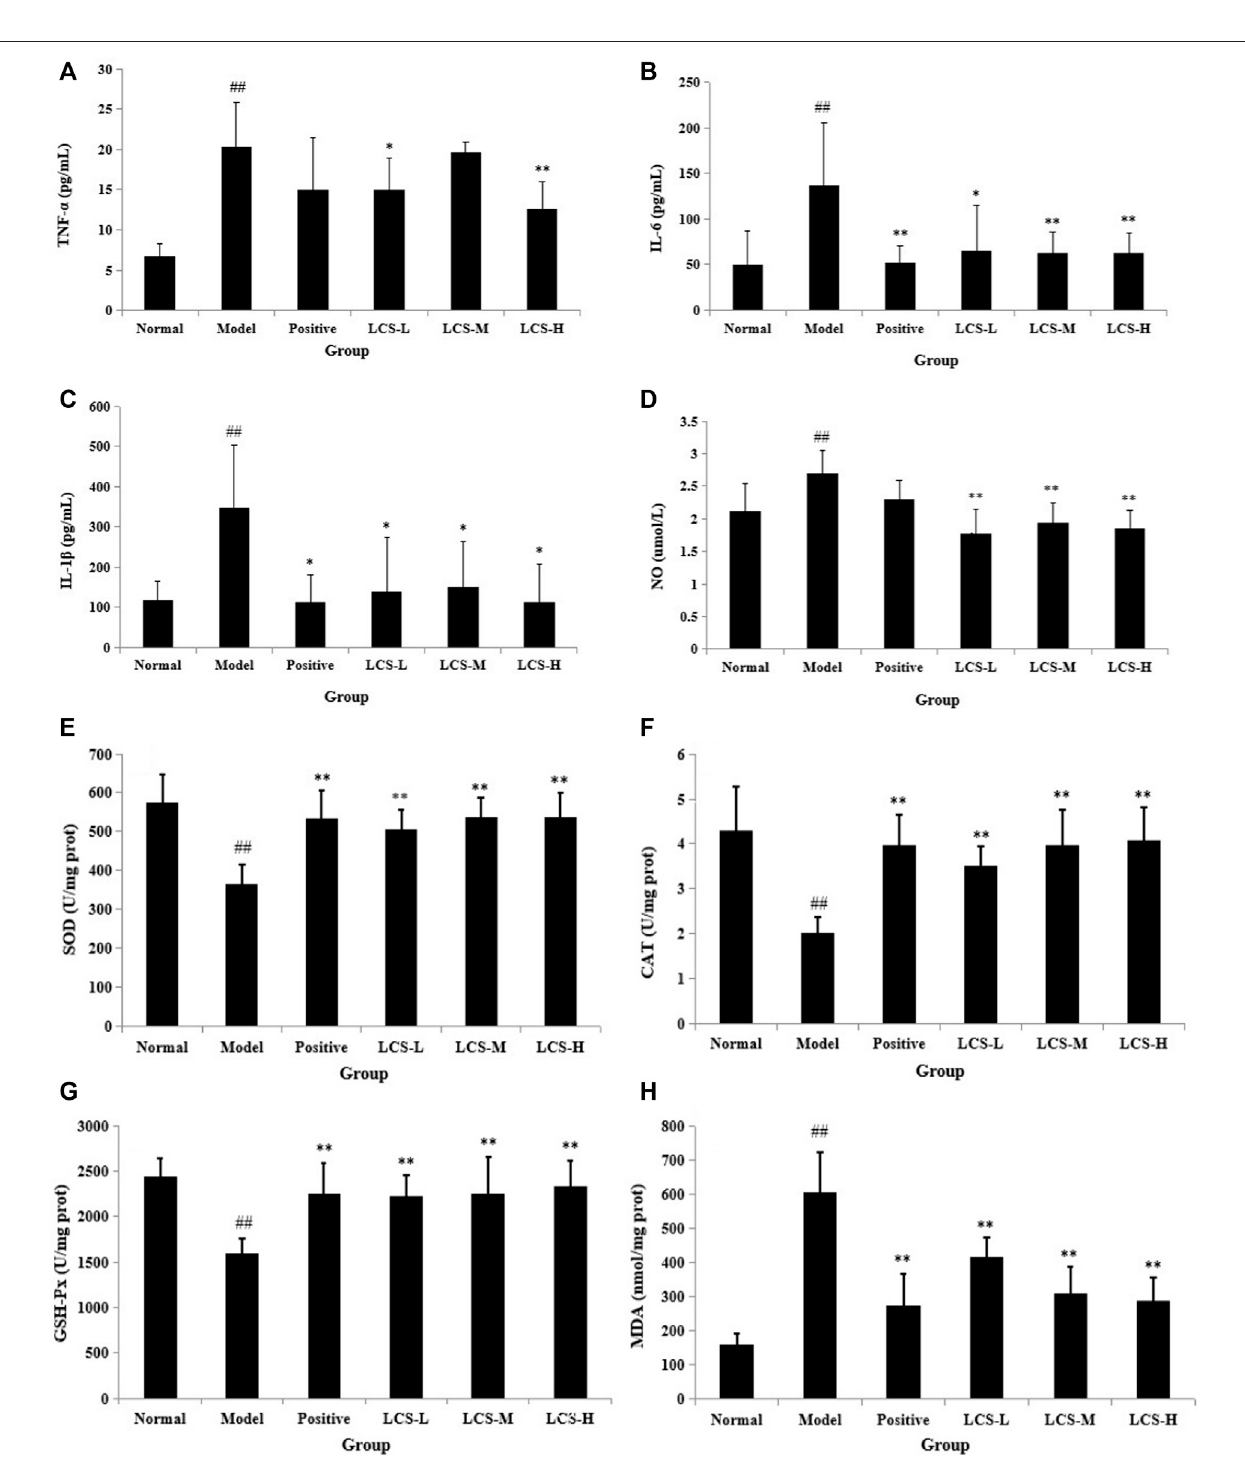
FIGURE 11 | Levels of biochemical indexes in rat serum treated by LCS. (A) TNF- α , (B) IL-6, (C) IL-1 β , (D) NO, (E) SOD, (F) CAT, (G) GSH-Px, and (H) MDA in rat serum treated by LCS. Note: The results are expressed as mean ±SD. ## Statistically signi fi cant differences p < 0.01, compared with the normal control group; ** statistically signi fi cant differences p < 0.01, compared with the model group; * statistically signi fi cant differences p < 0.05, compared with the model group. groups were signi fi cantly increased ( p < 0.01) and were near to of GSH-Px in the positive group. Moreover, the level of MDA normal and positive groups. Speci fi cally, all of the three dosages of signi fi cantly increased in the model group compared to that in the LCS groups showed equal or superior abilities to increase the activity normal control group ( p < 0.01, Figure 11H ). In comparison with